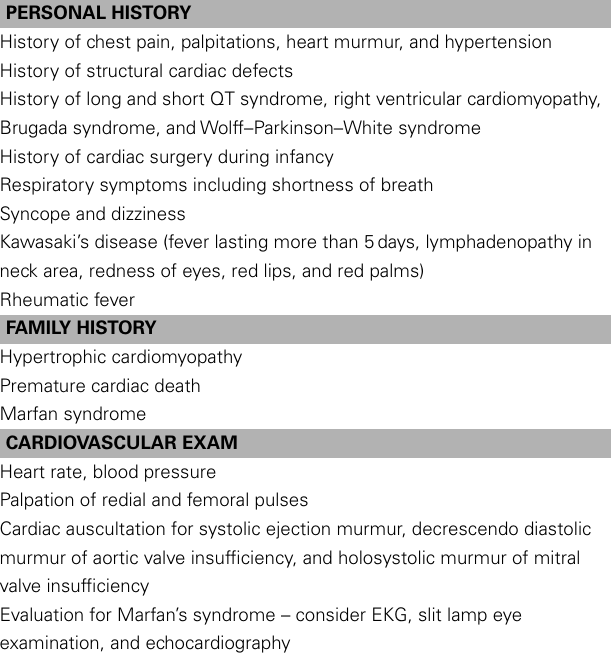
Table 2 | Cardiovascular screening